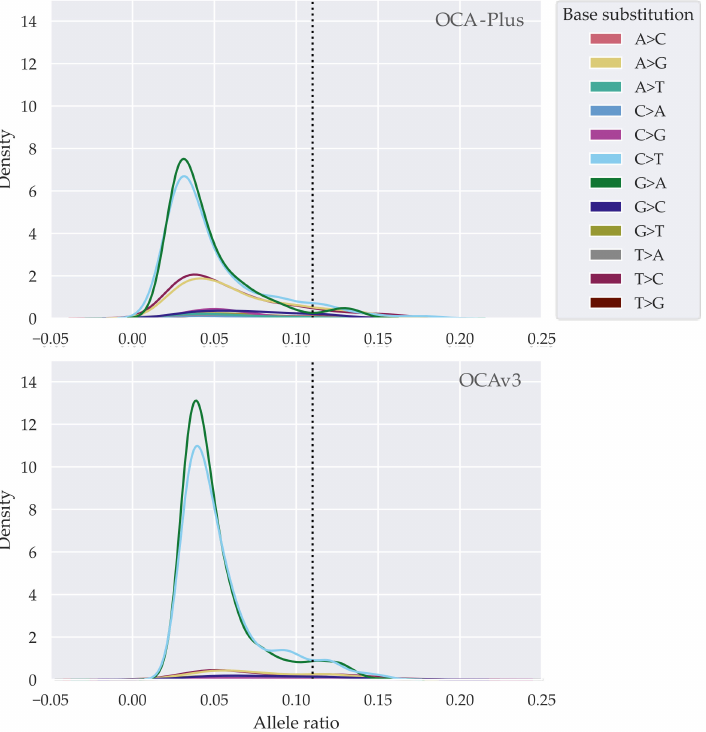
Figure 3. Allele frequency-based distribution of base substitutions of variants below first quartile. Dotted lines represent our determined cut-off value by an allele frequency of